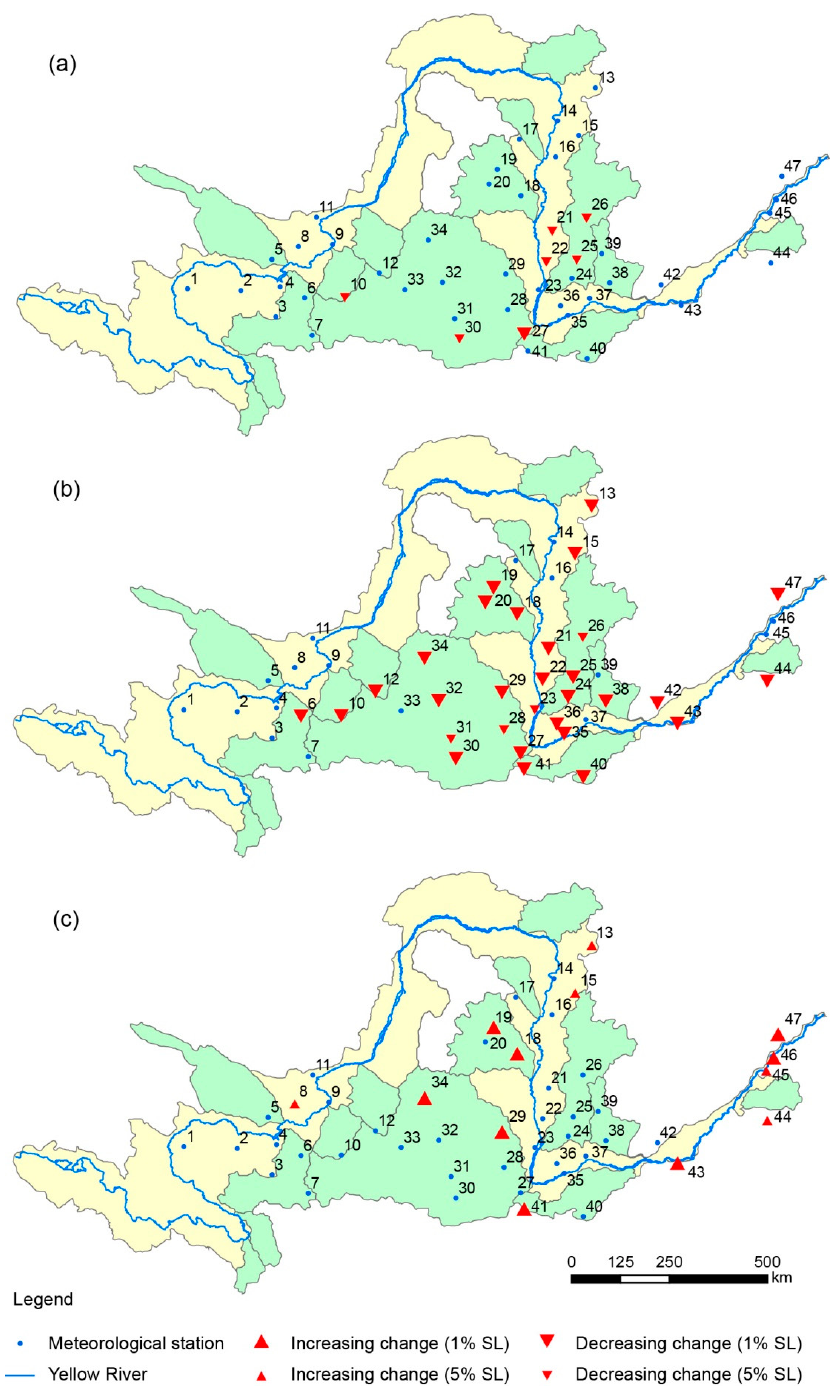
Figure 5. Significant changes in ( a ) annual rainfall; ( b ) rainy days and ( c ) average daily rainfall intensity in the Yellow River Basin detected by the PTM index. The abbreviation SL stands for signi fi cance